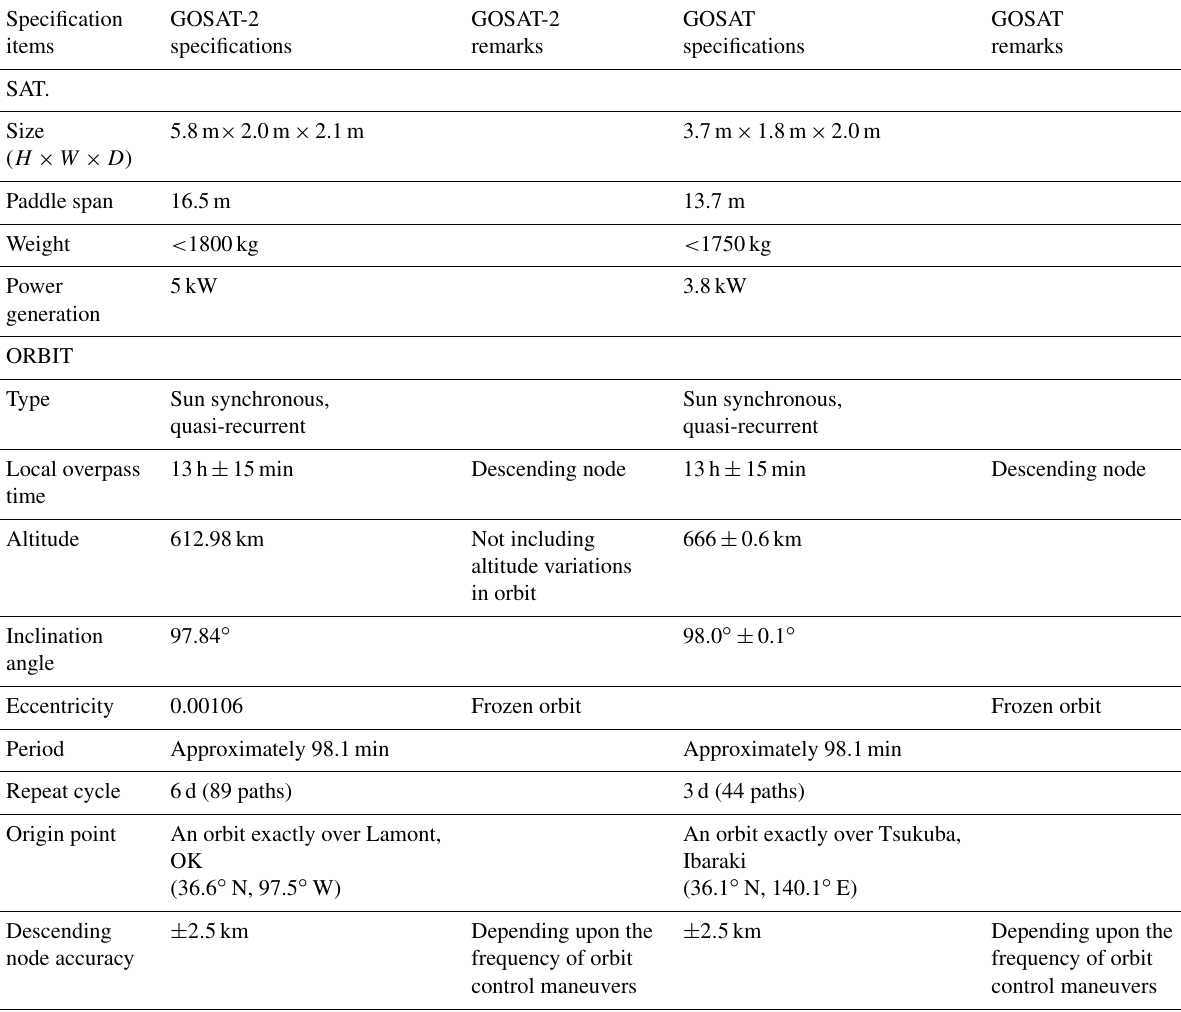
Table 1. Satellite and orbit parameters of GOSAT-2 and